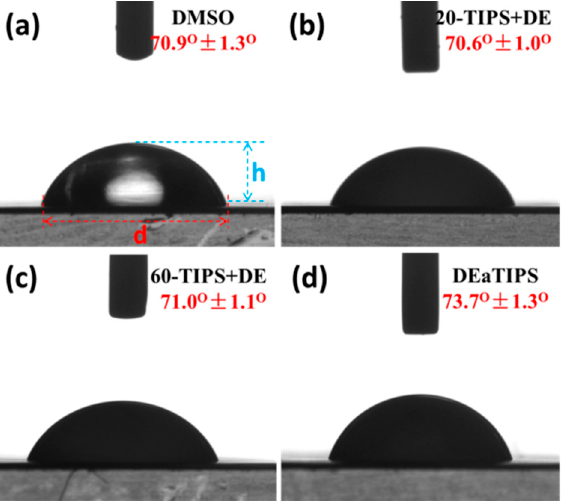
Figure 3. Droplet shape of ( a ) DMSO and the samples: ( b ) 20-TIPS + DE, ( c ) 60-TIPS + DE, ( d ) DEaTIPS.